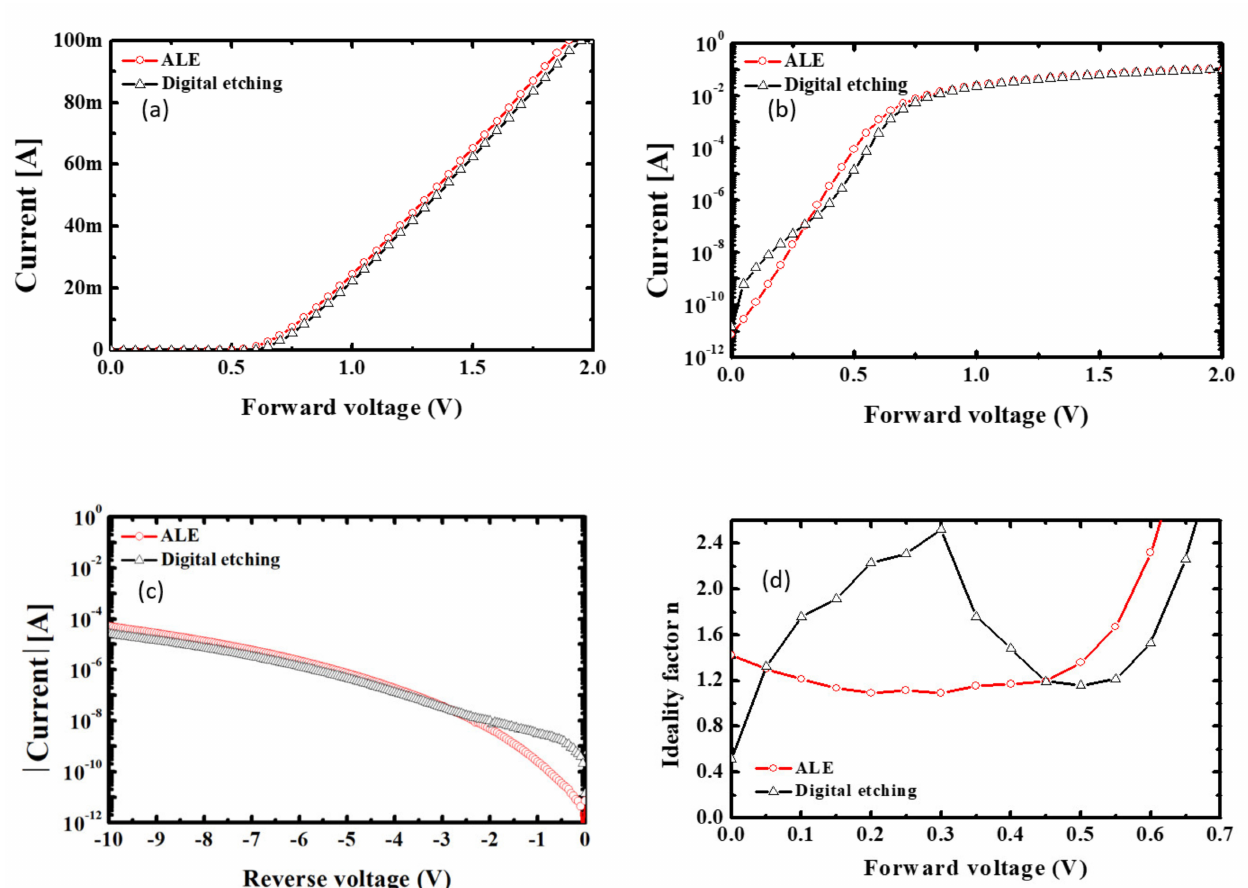
Figure 8. I – V curves of the fabricated Schottky diodes. ( a ) Forward I – V characteristics (linear scale), ( b ) forward I – V characteristics (log scale), ( c ) reverse I – V characteristics (log scale), and ( d ) ideality factors.